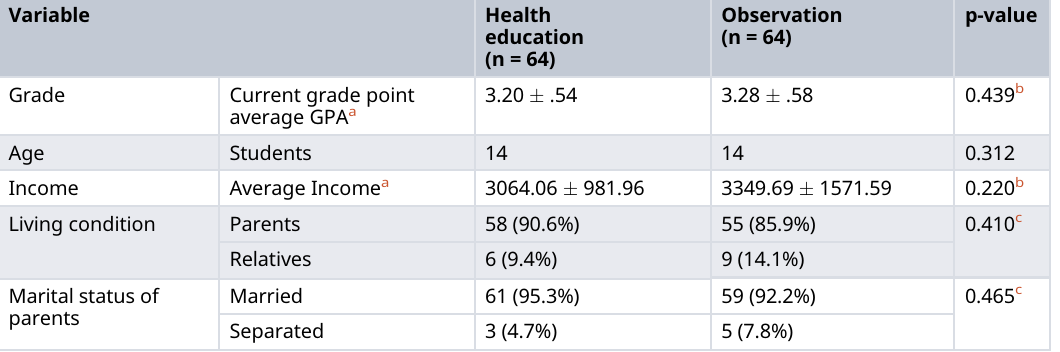
Table 1. Baseline characteristics of participants af both groups (n =